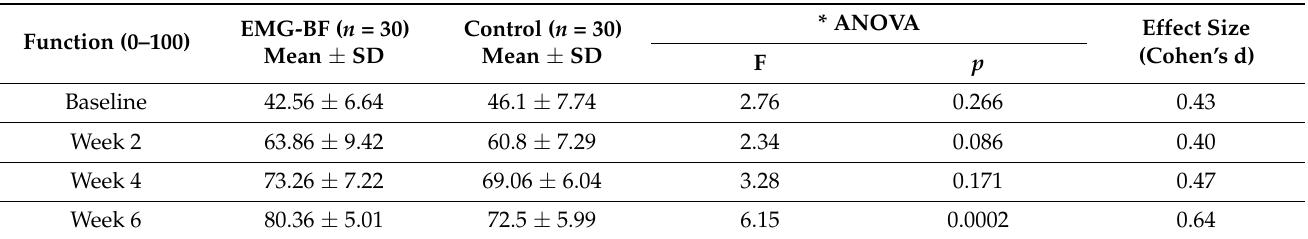
Table 4. Comparison of knee function between two